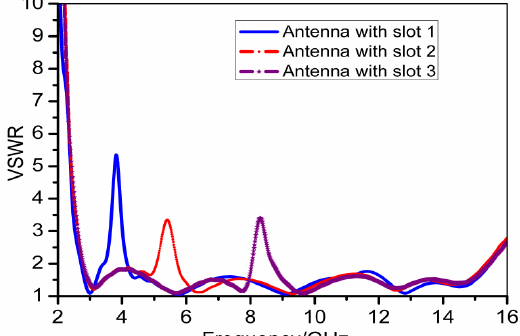
Figure 5: Simulated variation of VSWR with frequency in different considered antennas.